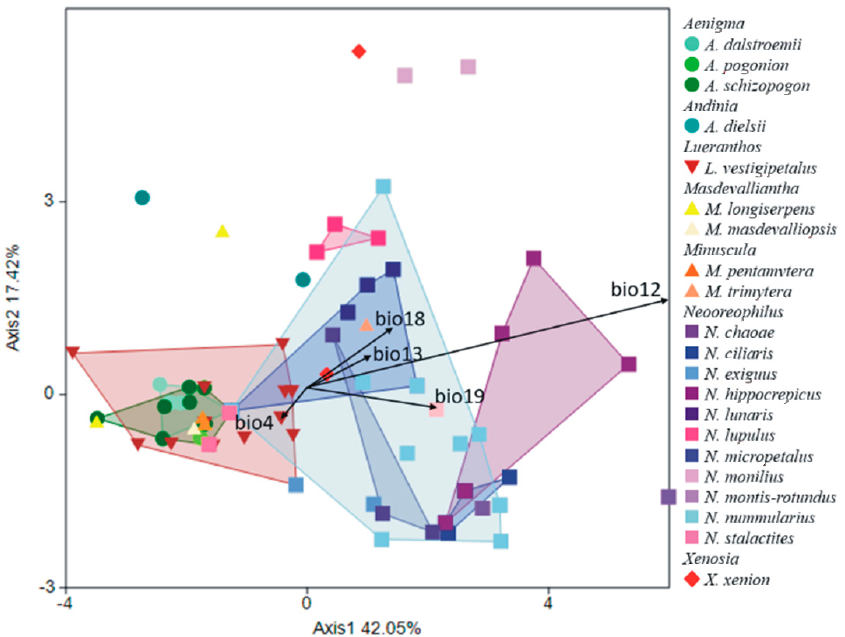
Figure 11. Canonical variate analysis (CVA) of the studied species along the climatic gradient. The relative contributions of bioclimatic factors are shown as vectors. Variables with low discriminating impact are omitted.